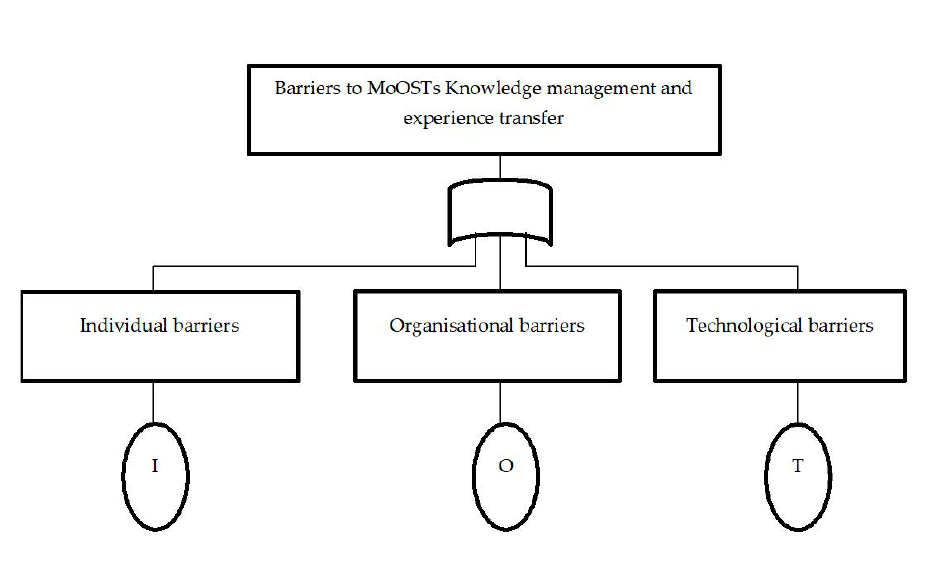
Figure 2. Global fault tree analysis for main classes of probable causes.